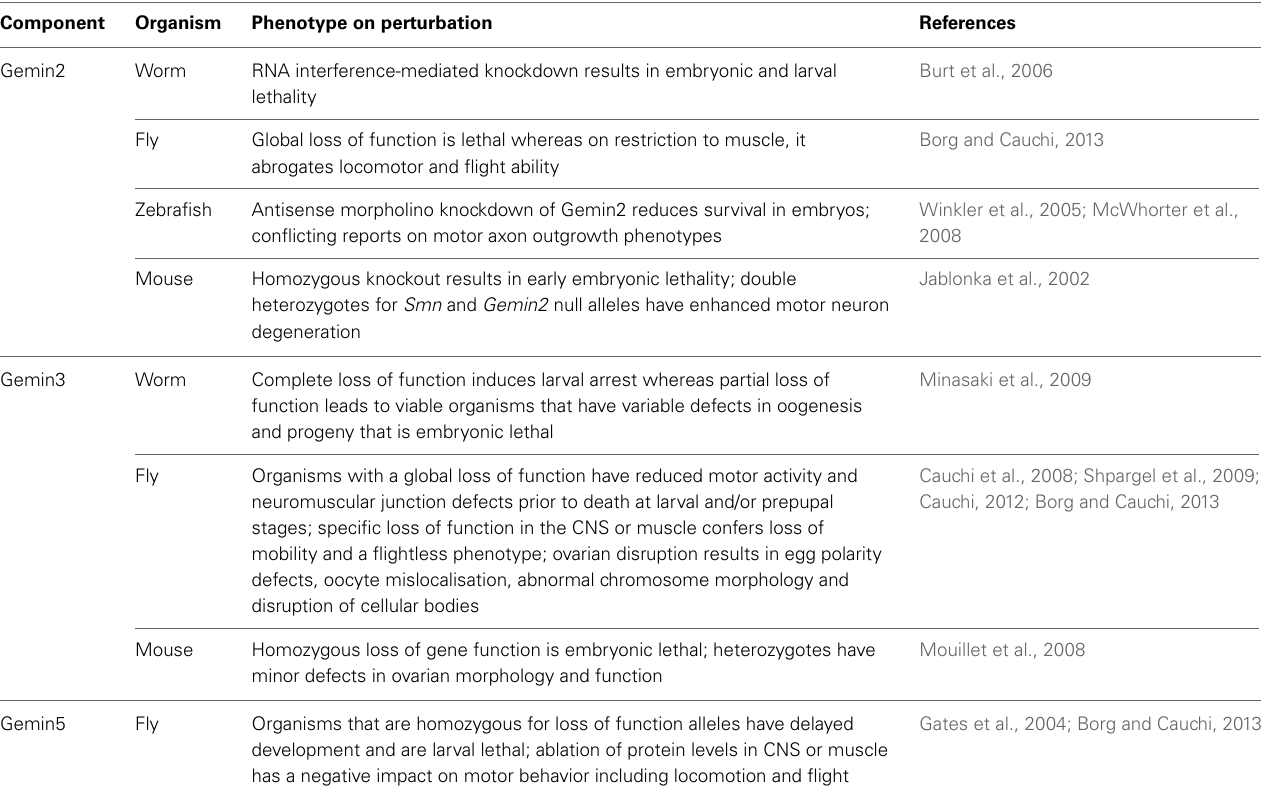
Table 1 | Phenotypes in Gemin-mutant multicellular model